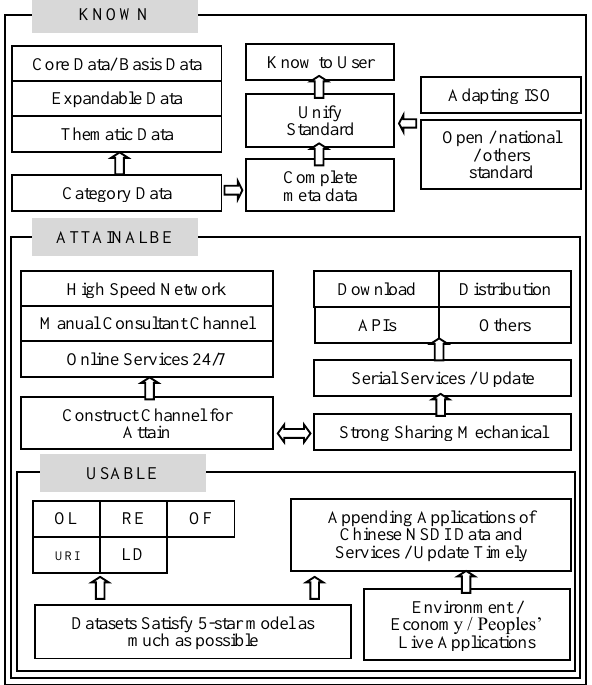
Figure 3. The technical framework of data and services